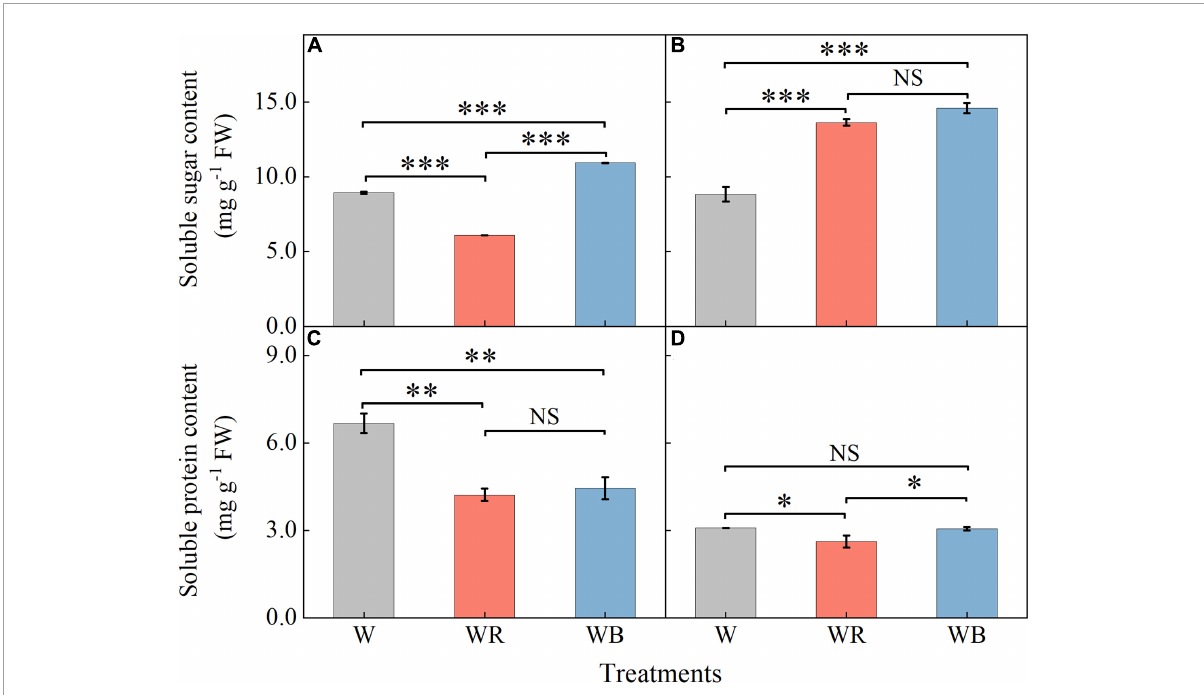
FIGURE3 The contents of soluble sugar and soluble protein in extracts of wheat seedlings leaves (A,C) and stems (B,D) under different treatments. Values represent the mean ± SE ( n = 3). The symbols ∗ , ∗∗ and ∗∗∗ indicate significance at the 0.05, 0.01, and 0.001 levels, respectively. NS, not significant, according to the Duncan’s